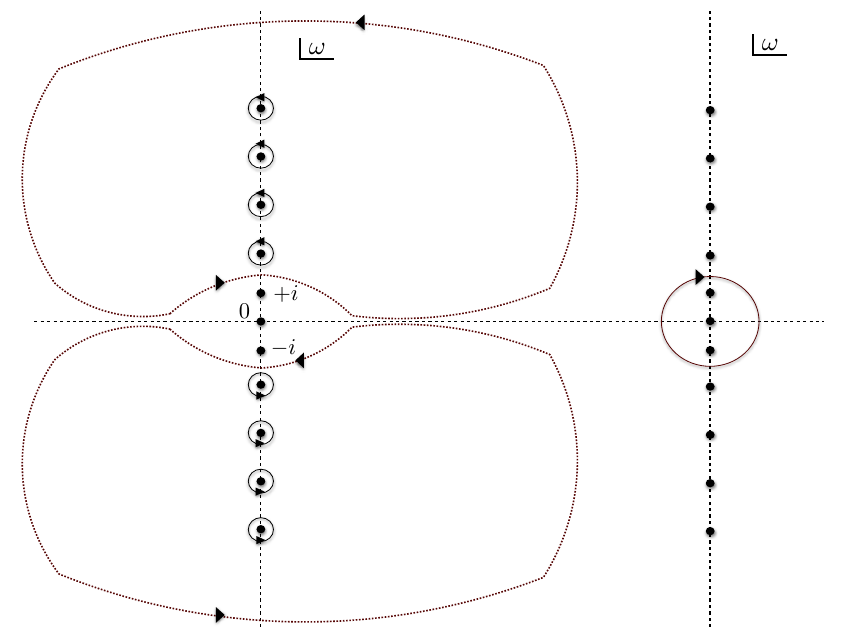
Figure 6 . This is a pictorial representation of performing the Matsubara summation via a contour integration. On the left, one gathers the residues at each pole, except the zero modes. Using the bounded-ness of the integrand as j ! j ! 1 , we can use an alternative contour, denoted by the dashed curve, which collects all the residues. When a similar contour is drawn in the lower half plane, the combined contour can equivalently be thought of as a contour around the